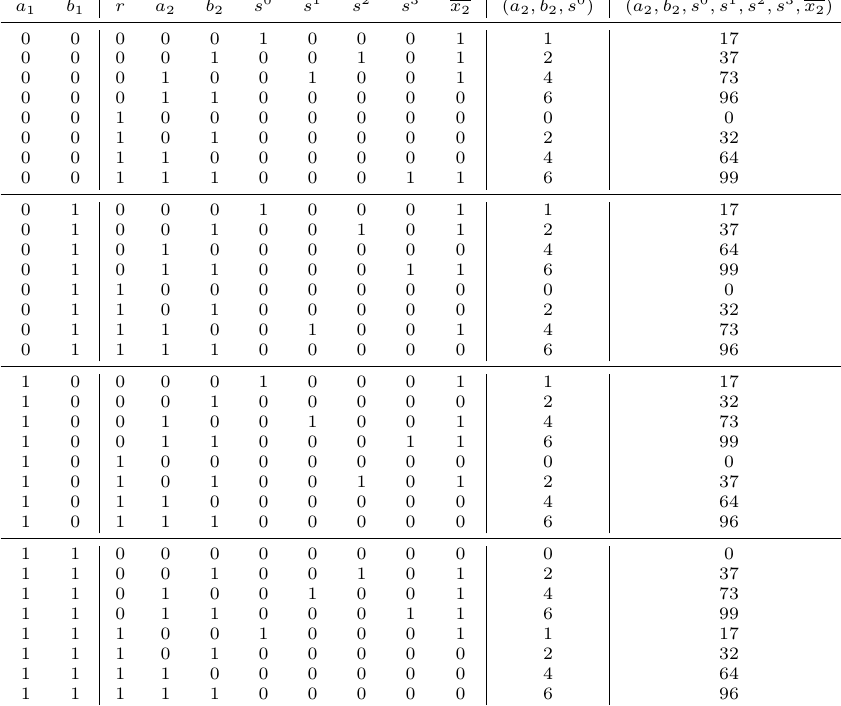
Table 4: Showing I ( O ; ( a 1 , b 1 ) | ( a 2 , b 2 ) ) = 0 for the LMDPL AND